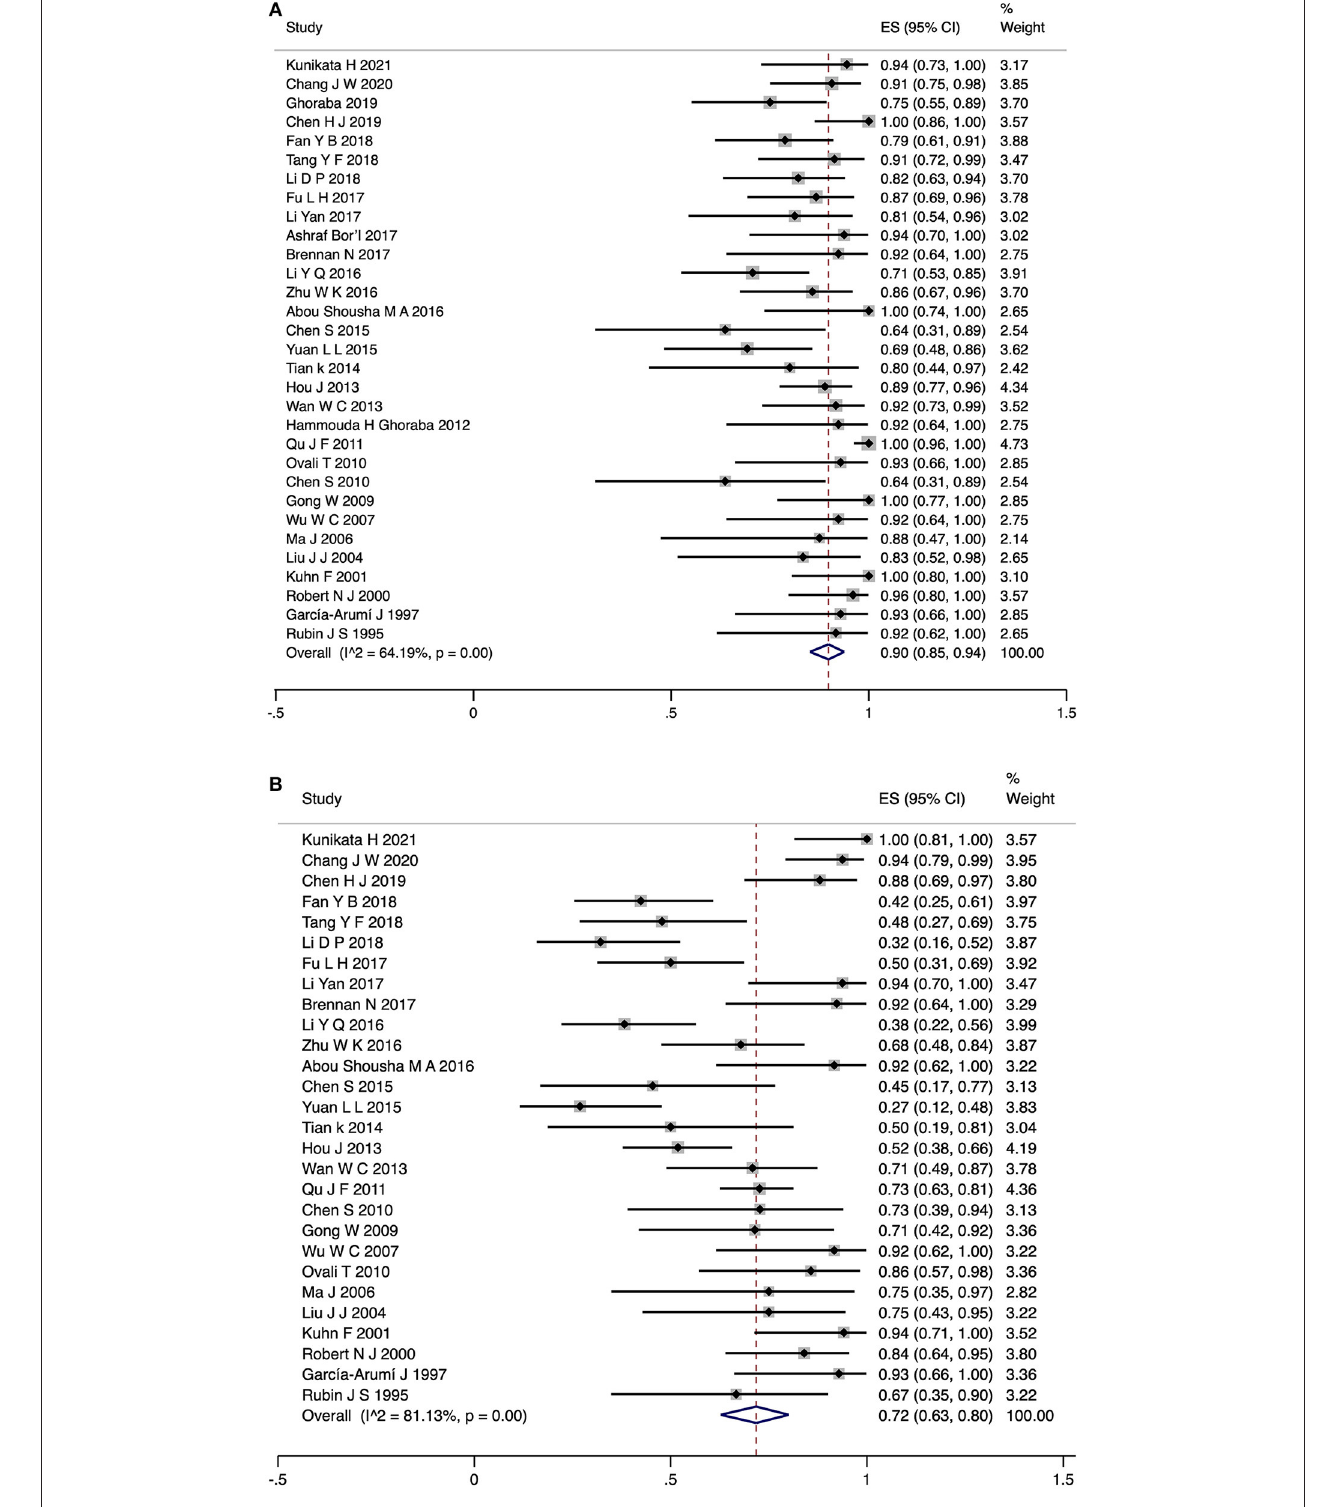
FIGURE 2 | Forest plot for TMH closure rate (A) and VA improvement rate (B) of surgery group patients. TMH, traumatic macular hole; VA, visual acuity.